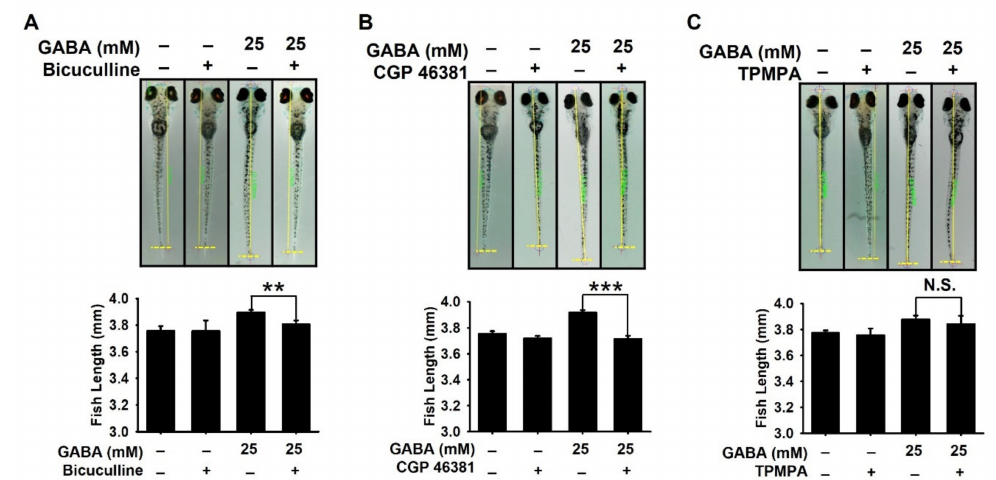
Figure 3. GABA A and GABA B receptors are responsible for GABA-mediated growth promotion in zebrafish larvae. Zebrafish larvae ( n = 20) at three days post-fertilization (dpf) were pretreated with 10 µ M each of ( A ) bicuculline (GABA A antagonist), ( B ) CGP 46381 (GABA B antagonist), and ( C ) TPMPA (GABA C antagonist) 2 h before treatment with 25 mM GABA. The media were replaced at 6 dpf with GABA, and total body length was measured at 9 dpf. Graphs represent the total body length ( bottom ). Significant differences among the groups were determined using Student’s t -test. All data are presented as mean ± standard error of the mean (** p < 0.01 and *** p < 0.001). N.S.,